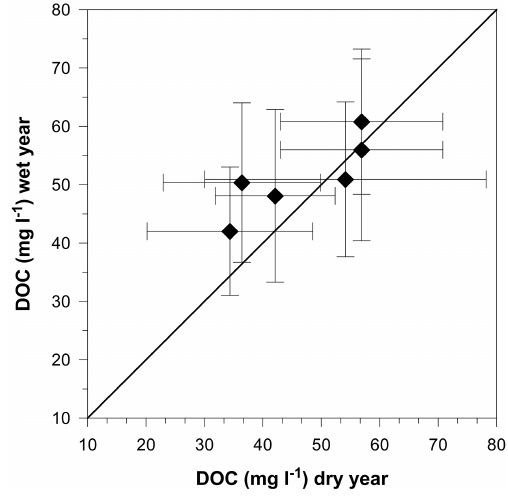
Figure 3. Average ( ± standard deviation) DOC concentrations in the dry winter of 2006/2007 and in the wet winter of 2007/2008 in the dip wells of transect